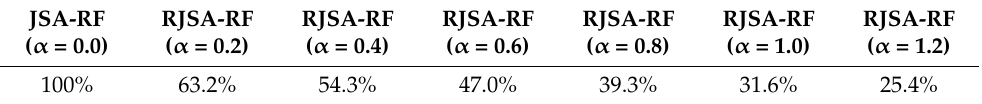
Table 4. The percentage of frames preserved after extraction of different energy prominence regions.